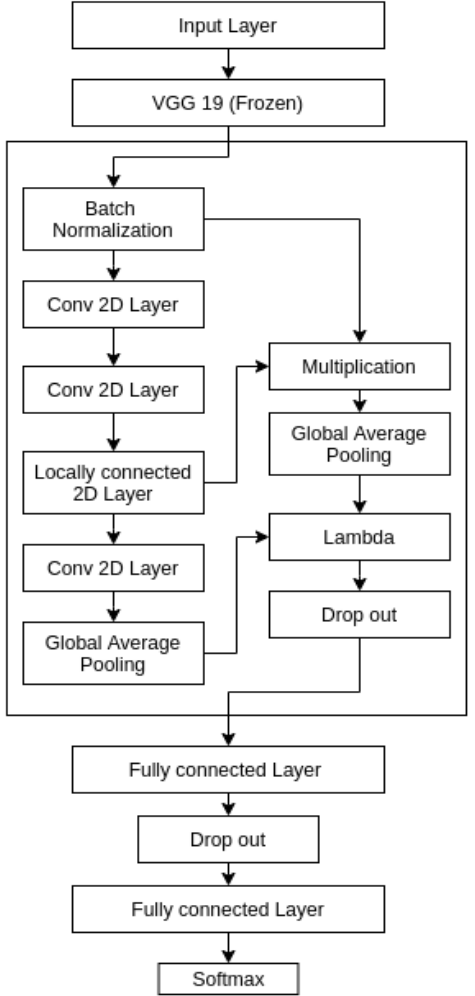
Figure 8. Proposed model architecture along with the attention generation mechanism.